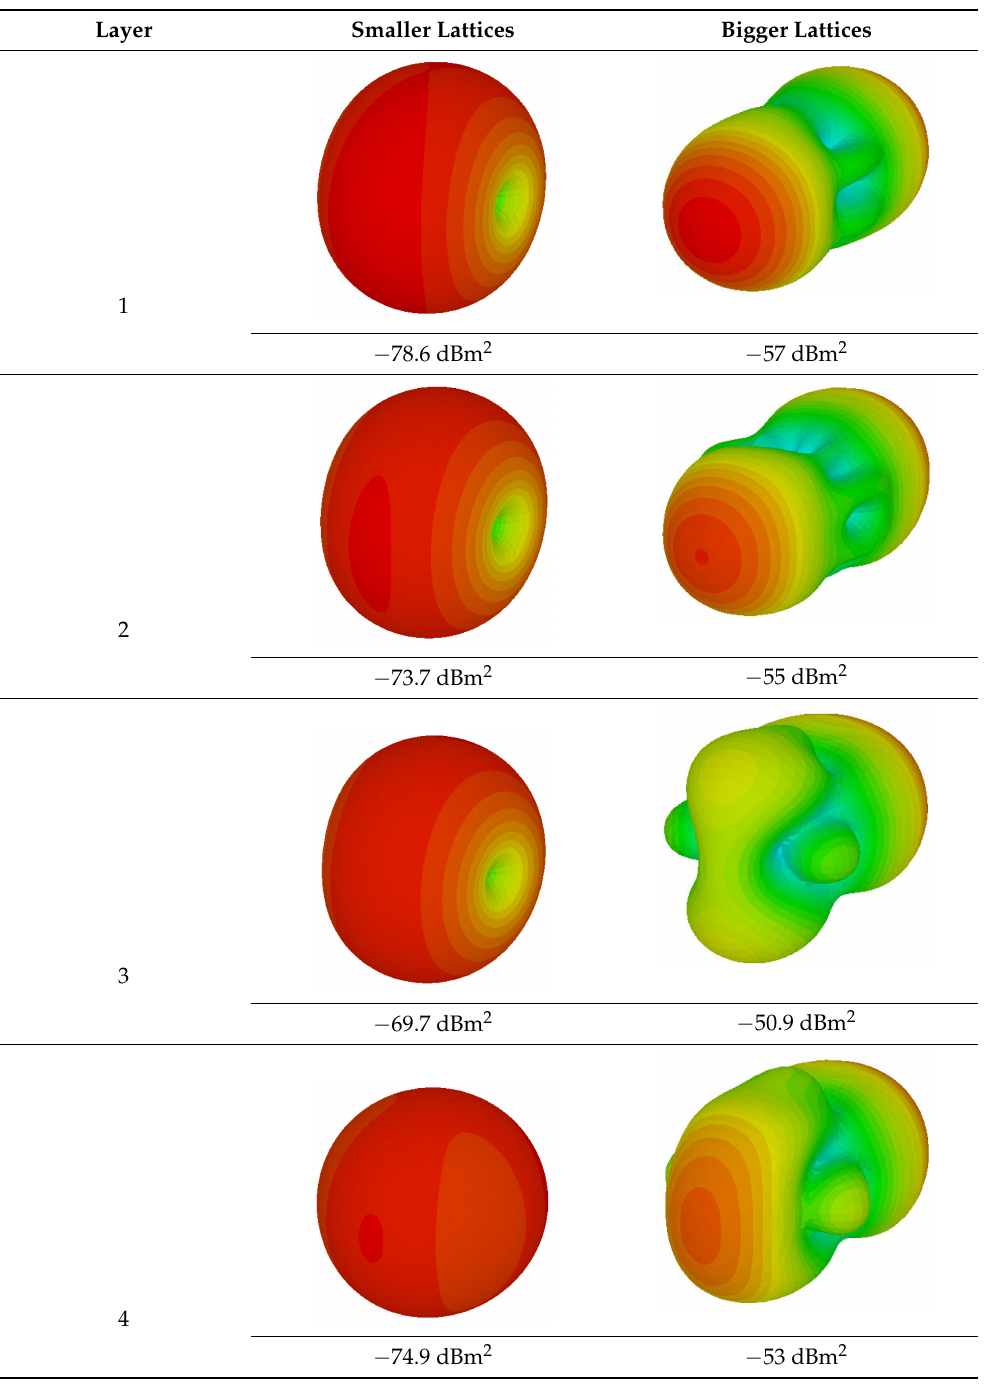
Table 6. Bistatic RCS scattering patterns of coding metamaterial with 4 and 16 lattices at 0.84